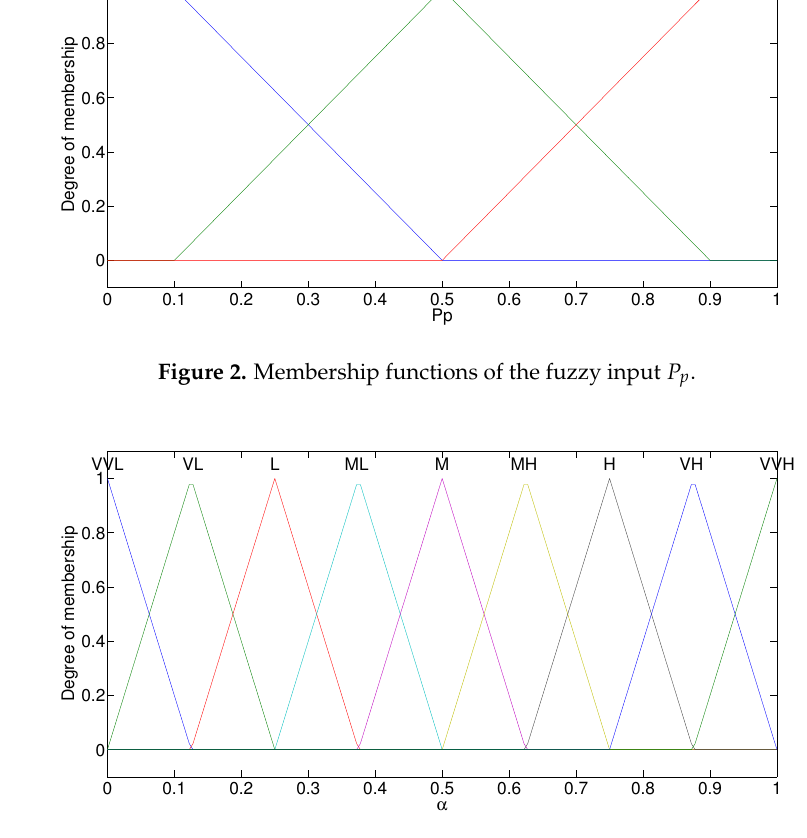
Figure 3. Membership functions of the fuzzy output α